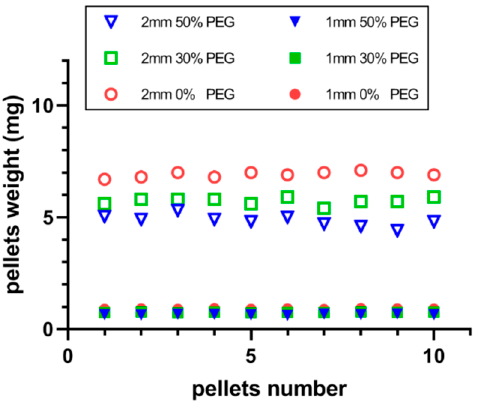
Figure 4. Weight uniformity of the printed pellets with different formulations.